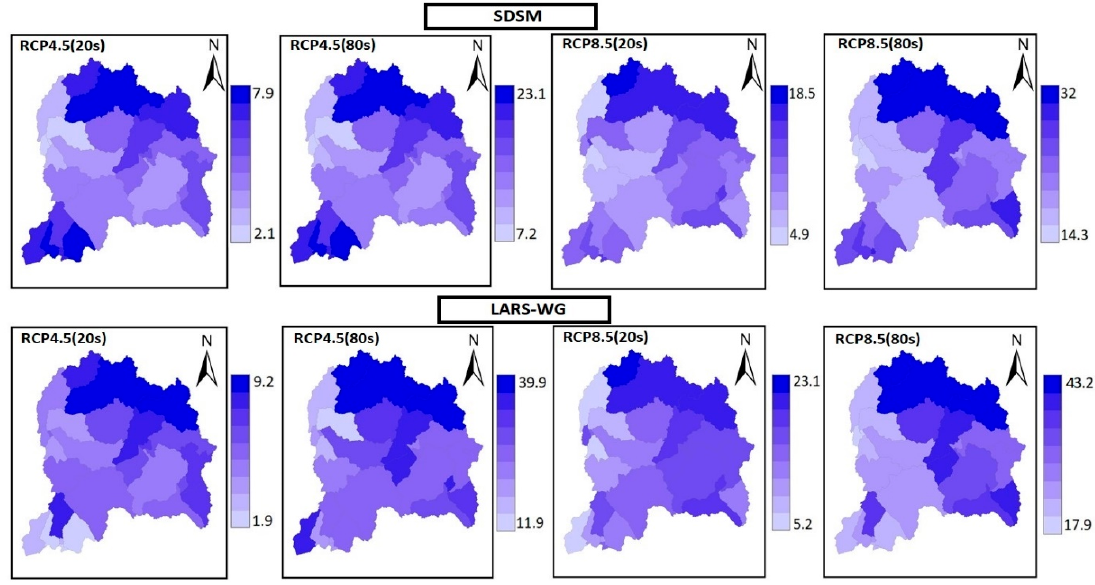
Figure 12. Spatial distribution of relative change rate (%) in actual evapotranspiration in the Jhelum River Basin with SDSM and LARS-WG under RCP4.5 and RCP8.5.